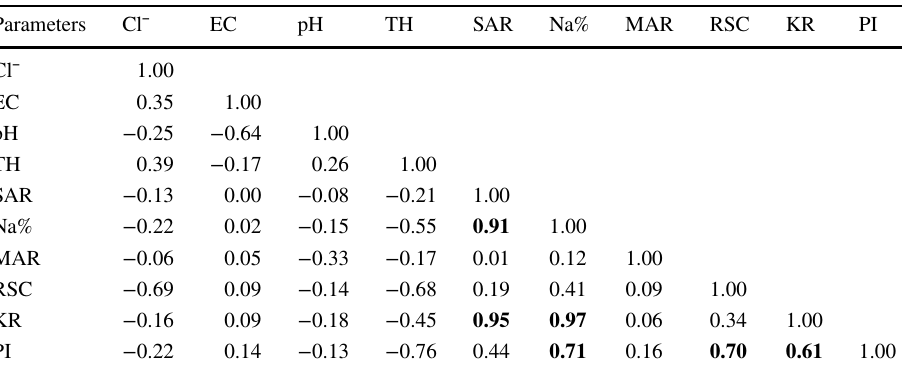
Bold values indicate correlation greater